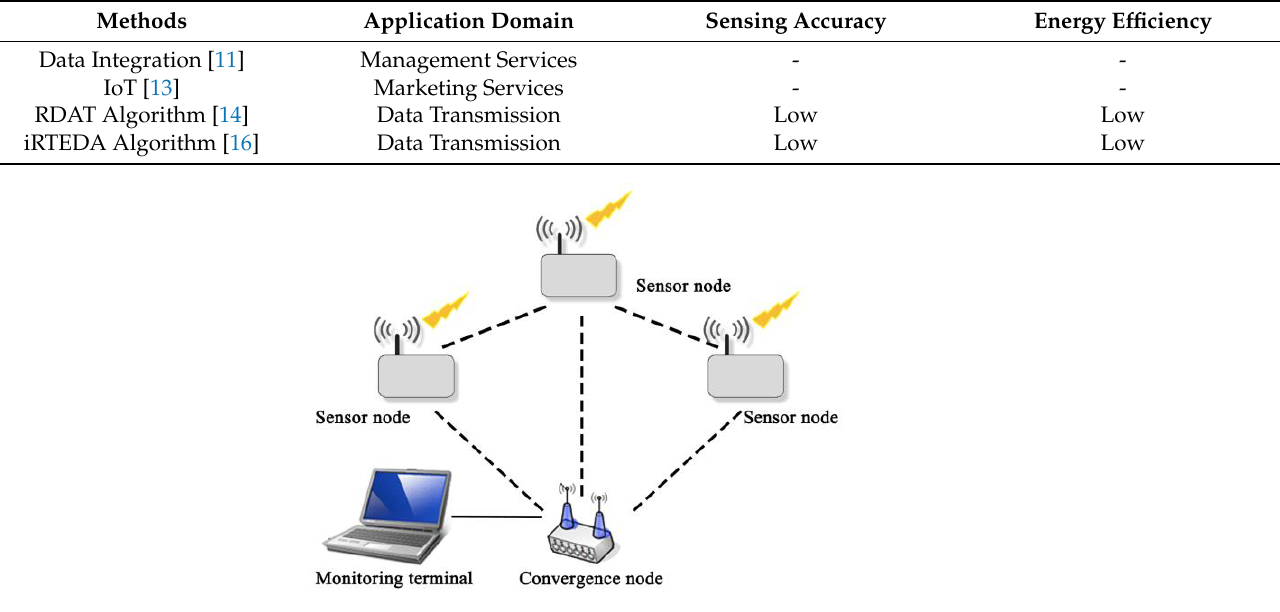
Table 1. Description of smart tourism application.